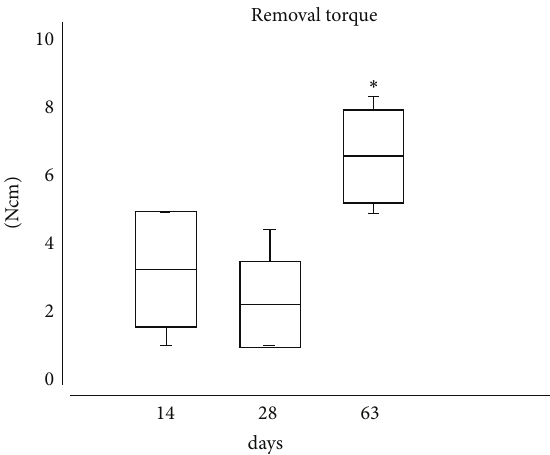
Figure 2: Box-plot representation of the experimental groups (mean, standard deviation, and minimum and maximum values). ∗ S tatistically significant difference in comparison to the 14-day and 28-day time points (ANOVA, p =